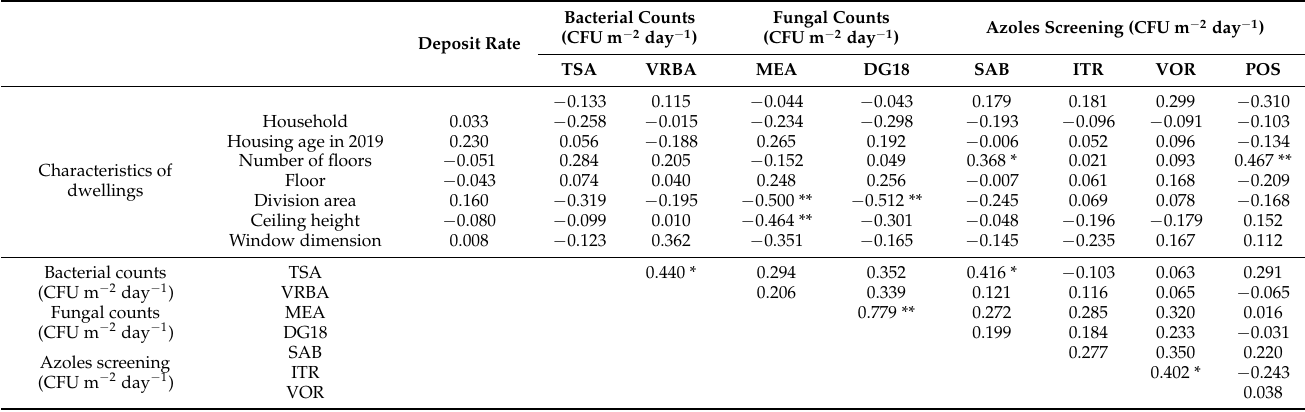
Table 4. Study of the relationship between housing characteristics, bacterial counts (tryptic soy agar (TSA) and violet red bile agar (VRBA)) and fungal counts (malt extract agar (MEA) and DG18) and azoles screening (in SAB, ITR, VOR and POS): Spearman correlation